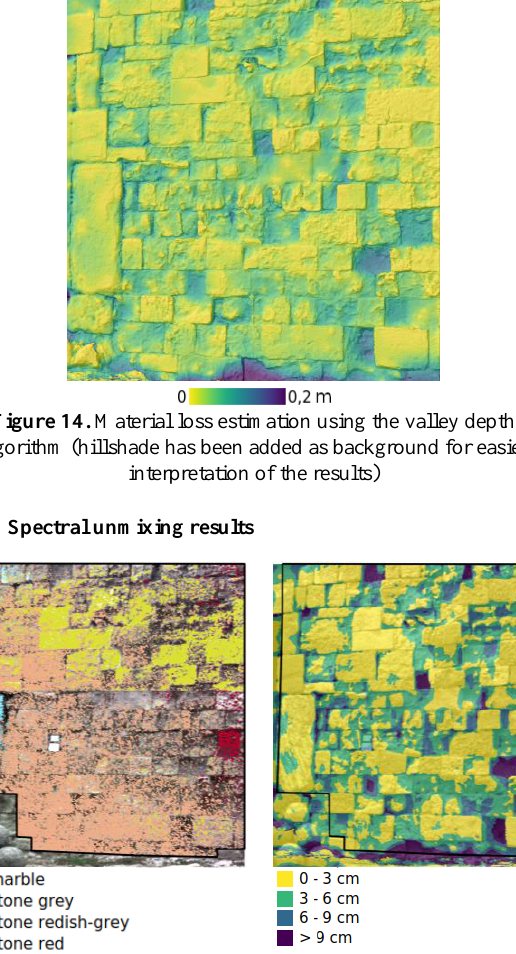
Figure 15. Left image: Building material map derived from MTMF spectral unmixing. Right image: Valley depth classes for the 3D model of the same wall (St. Nikolas Fort).